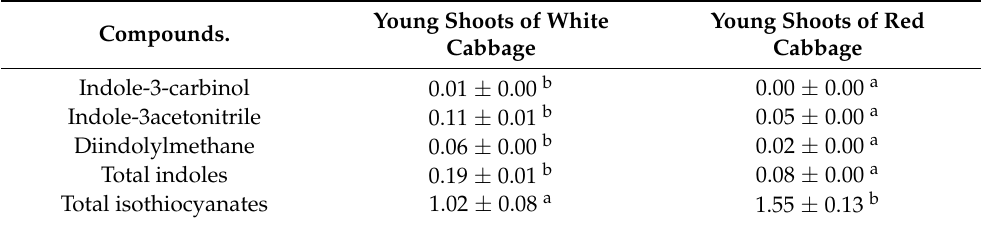
Table 2. Content of decomposition products in young shoots of white cabbage and young shoots of red cabbage ( µ mol/g